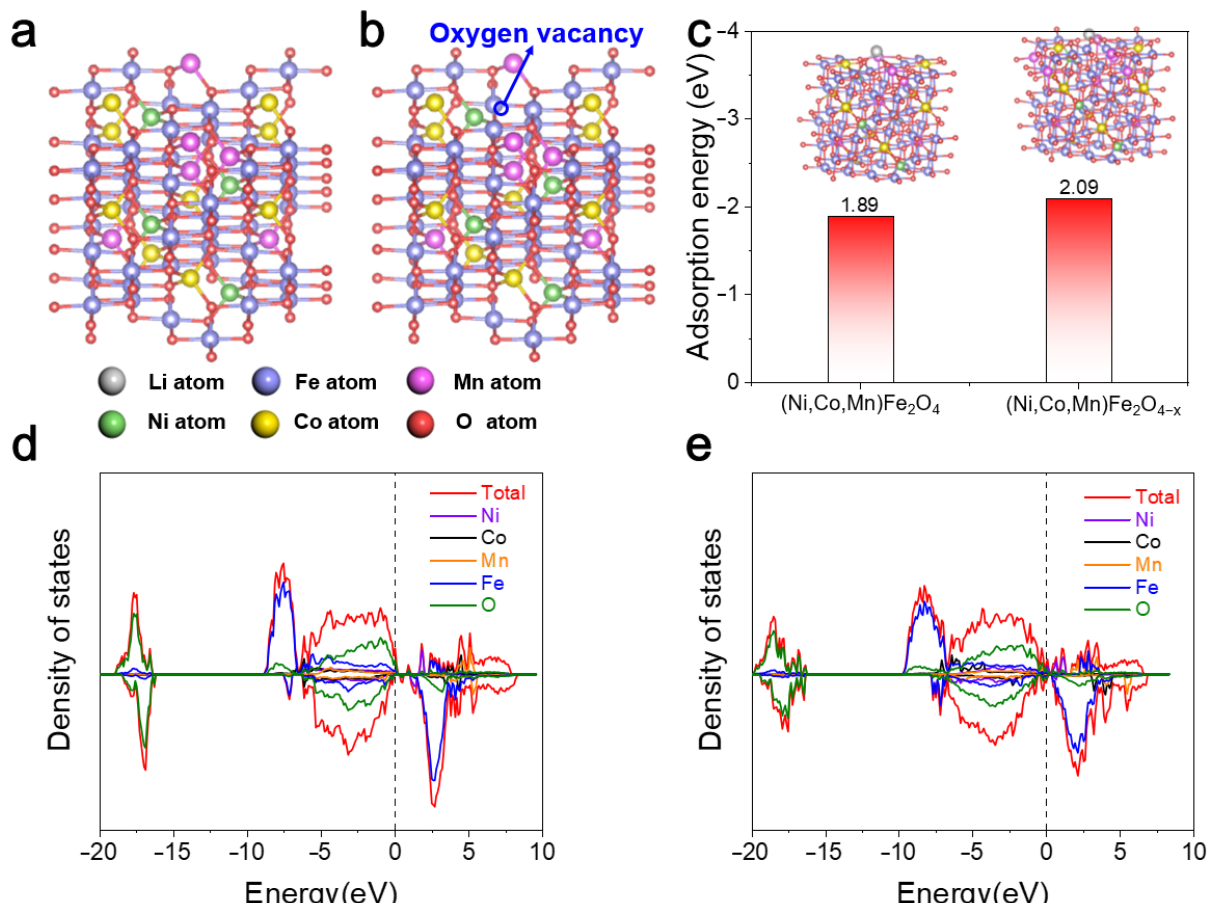
Figure 7. Crystal structures of ( a ) (Ni,Co,Mn)Fe 2 O 4 and ( b ) (Ni,Co,Mn)Fe 2 O 4 − x . ( c ) Calculated adsorption energy of Li on the surface of (Ni,Co,Mn)Fe 2 O 4 and (Ni,Co,Mn)Fe 2 O 4 − x (insert: optimized Li adsorption configuration). Density of states of ( d ) (Ni,Co,Mn)Fe 2 O 4 and ( e ) (Ni,Co,Mn)Fe 2 O 4 − x .